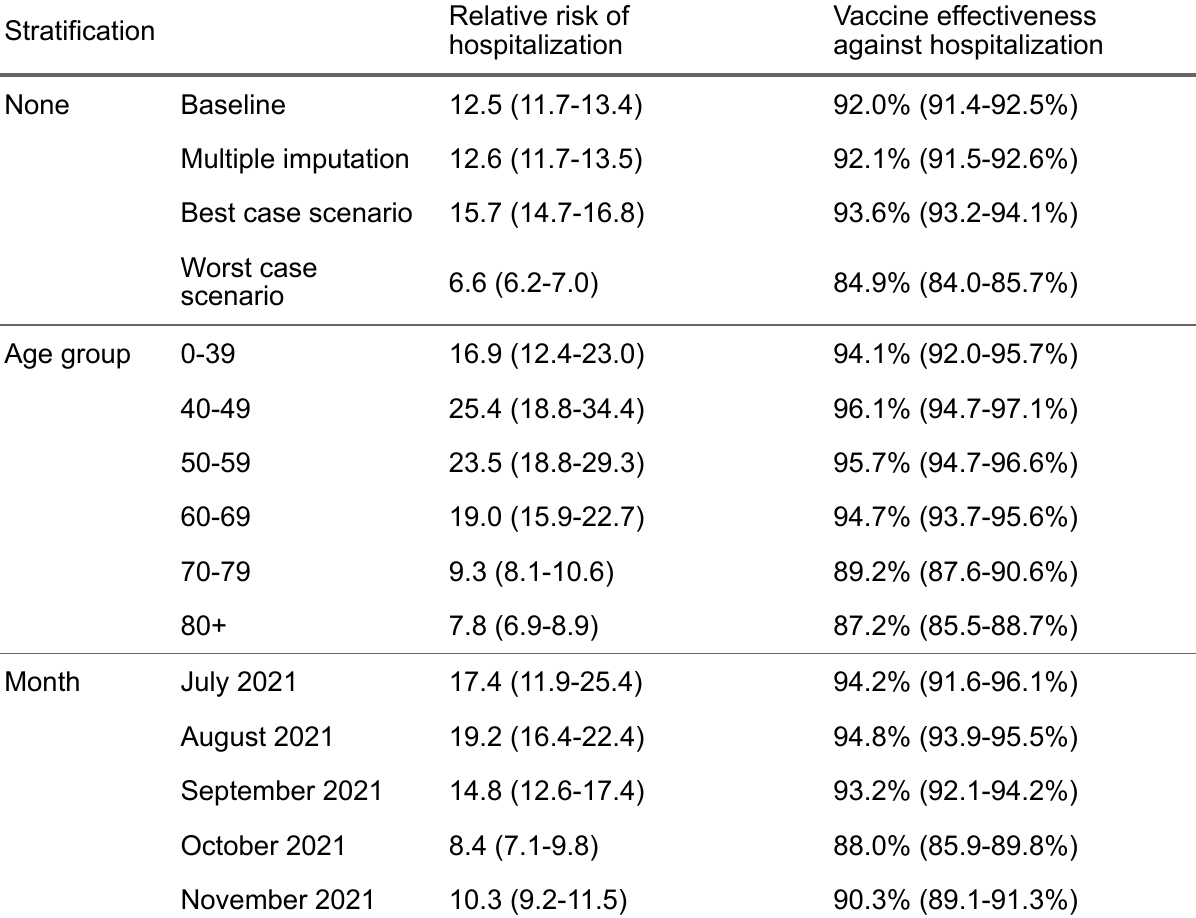
Table S1. Relative risk of hospitalization (and 95% confidence intervals) for non-fully vaccinated compared to fully vaccinated, with the corresponding estimations of vaccine eectiveness against hospitalization.